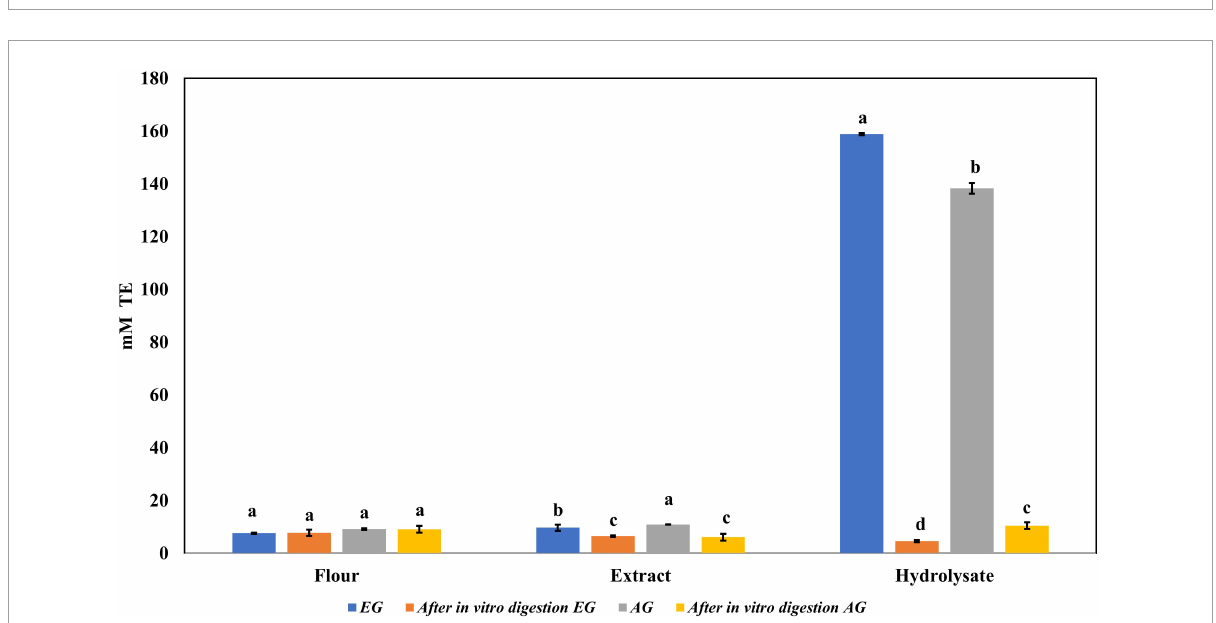
FIGURE6 Antioxidant activity against 2,2-diphenyl-1-picrylhydrazyl (DPPH) of flour, extracts, and hydrolysates of early grasshopper (EG) and adult grasshopper (AG) before and after in vitro protein digestion. Results are expressed in millimolar trolox equivalents (mM TE)/gram dry weight. Different letters between bars indicate a significant difference ( p -value <